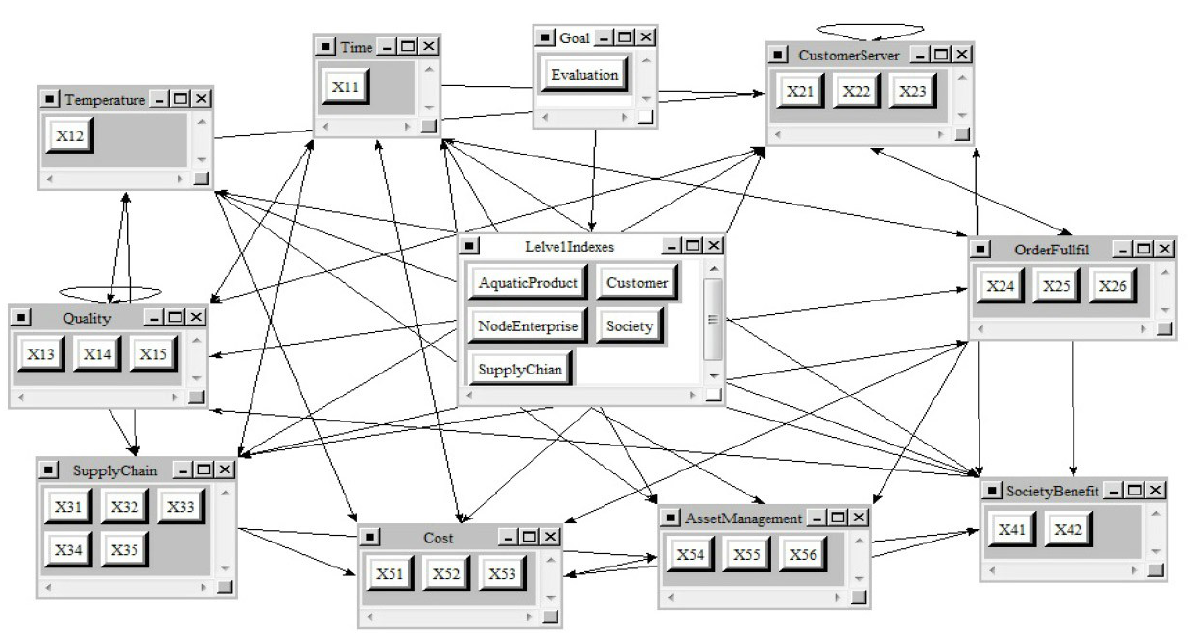
Figure 3. The ANP model of evaluation